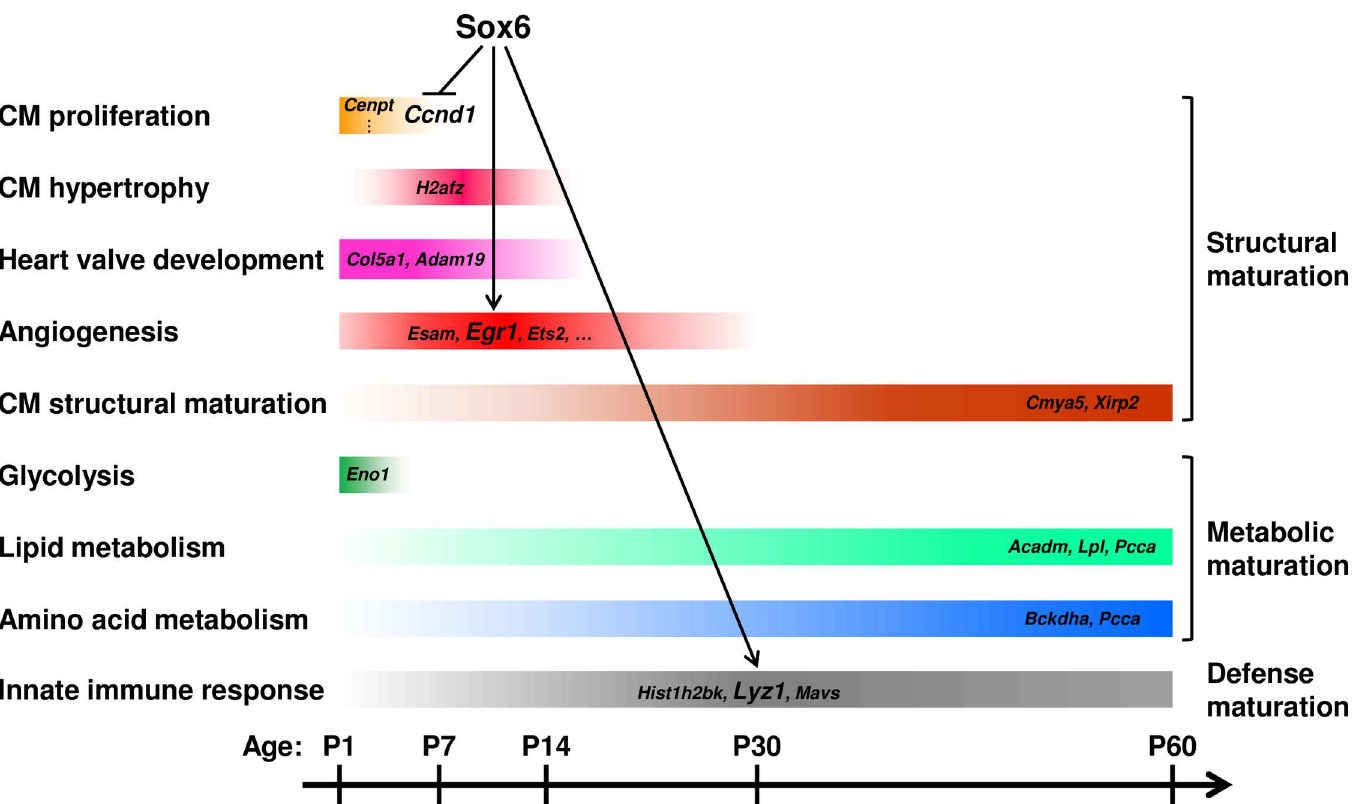
Fig 5. Schematic representation of key events and inferred roles of Sox6 during postnatal heart development in mice. Temporal changes of key events duringpostnatalheart development in control mice are demonstrated together with associatedhub genes. Inferred roles and potentialtargets of Sox6 are also shown with arrows and larger labels.CM: